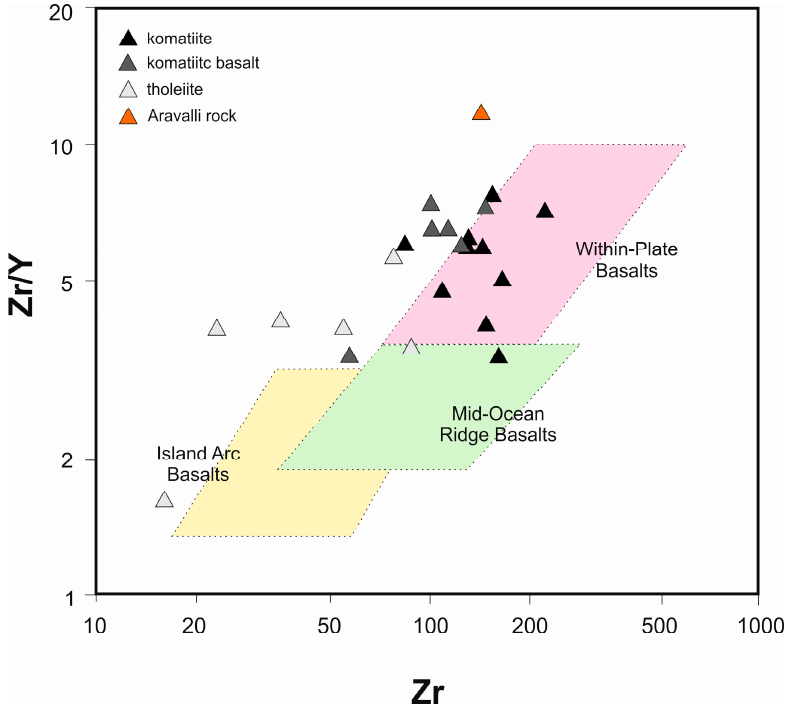
Figure 12. Zr/Y vs. Zr diagram after [46]. Figure 12. Zr / Y vs. Zr diagram after